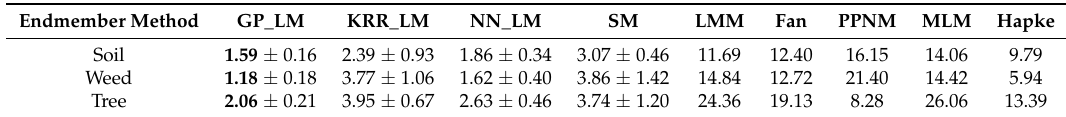
Table 4. RMSE (100 runs) of 360 test pixels of the ray tracing dataset. The best performances are denoted in bold.